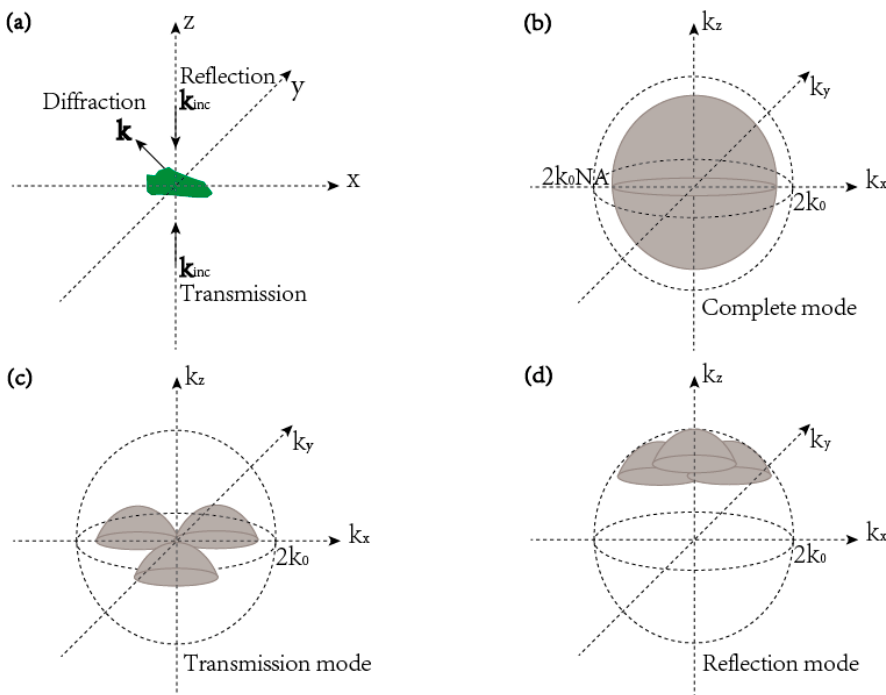
Figure 6. A description of different configurations of tomographic diffractive microscopy (TDM) and the corresponding accessible frequency domains. ( a ) The different configurations of TDM. ( b ) The accessible frequency domain for complete configuration. ( c ) The accessible frequency domain for transmission configuration. ( d ) The accessible frequency domain for reflection configuration.